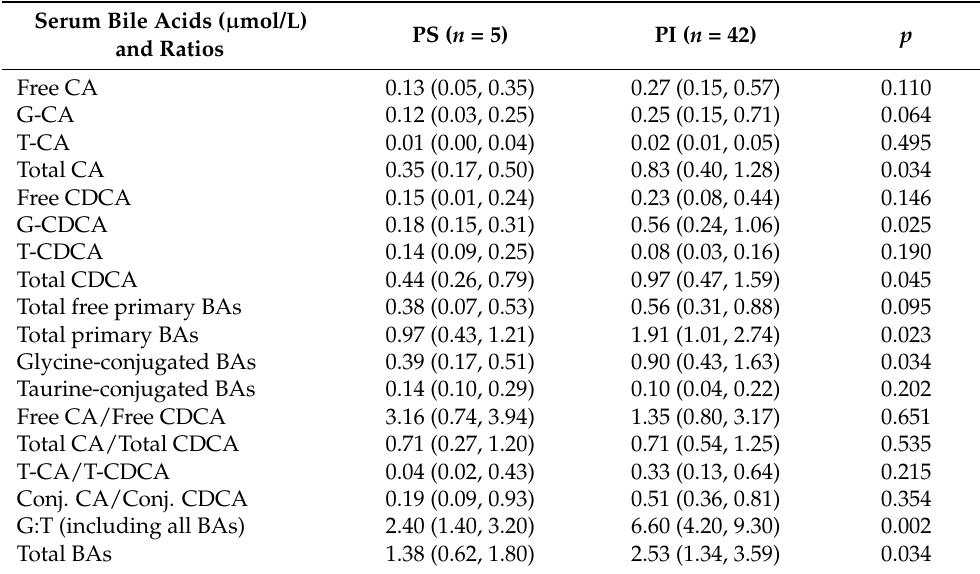
Table 5. Serum bile acids distribution in different subgroups classified according to their pancreatic sufficiency status (median and [Q 1 , Q 3